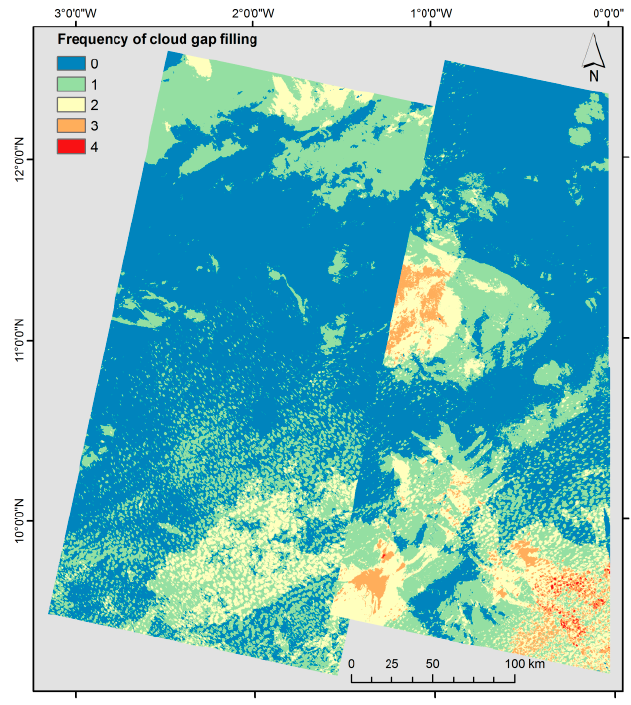
Figure 5. Map of the study area showing how often a pixel in the input Landsat time series of 2014 was filled.